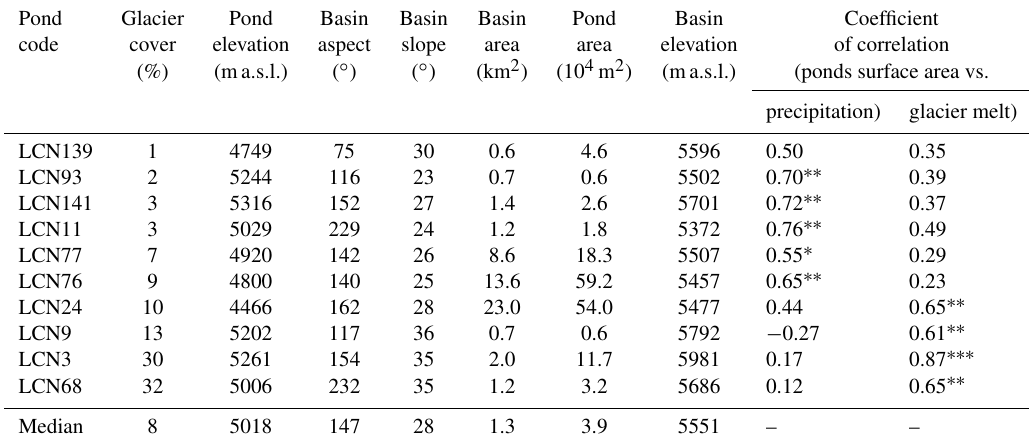
Table 4. Morphometric features of 10 selected ponds considered in the 2000–2013 analysis. Data are from 2013. Coefficients of correlation are for the monsoon season. The relationships with the other seasons are reported in Table S5.